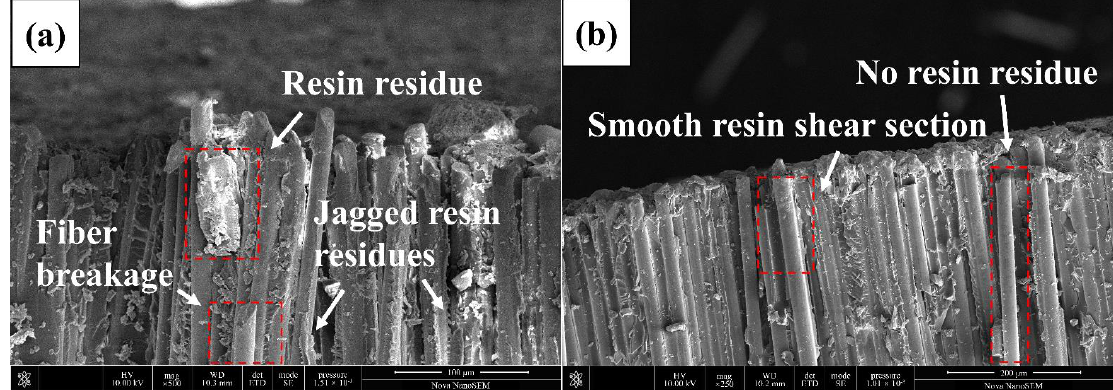
Figure 13. Glass fiber core rod section ( a ) and basalt fiber core rod section ( b ).